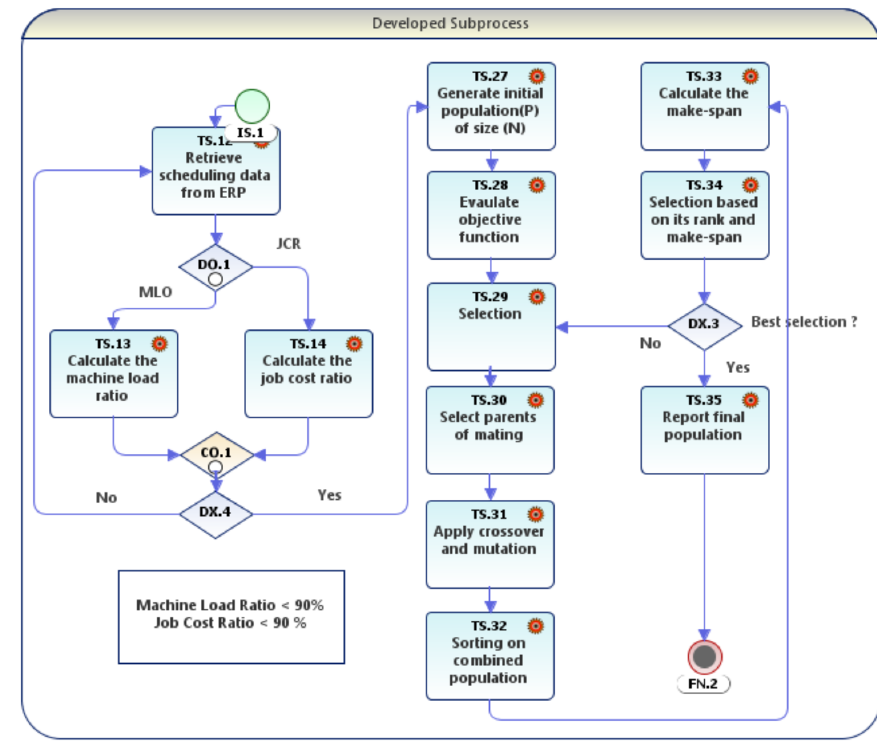
Figure 6. Multibroker (MB)–genetic-algorithm (GA) optimization